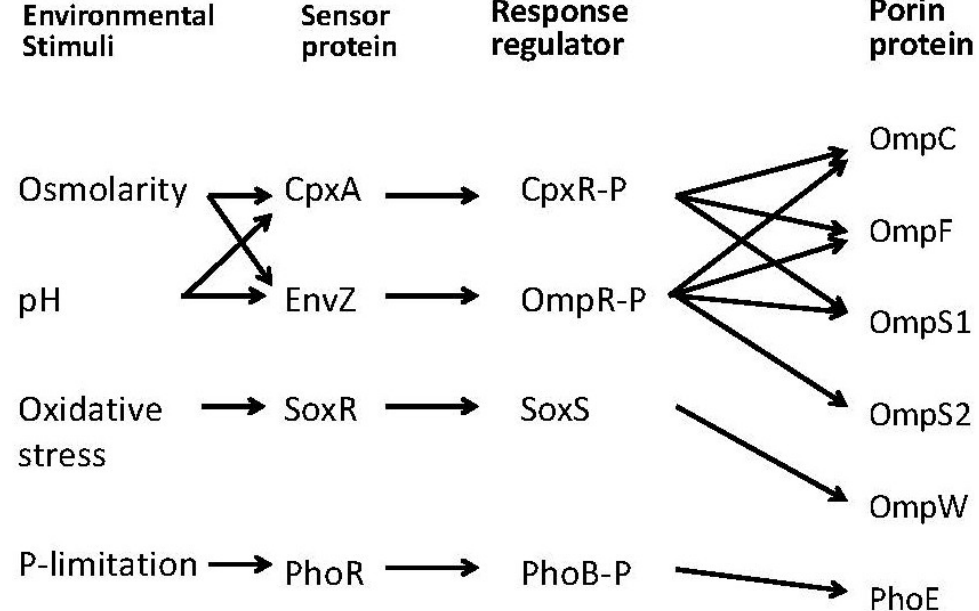
Figure 2. Regulation of porin genes in response to culture